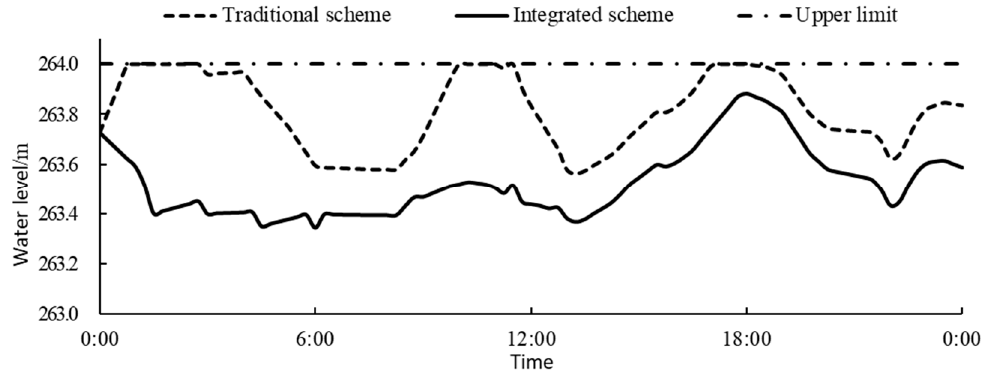
Figure 5. Water level variation of each scheme in the 2nd operating condition.